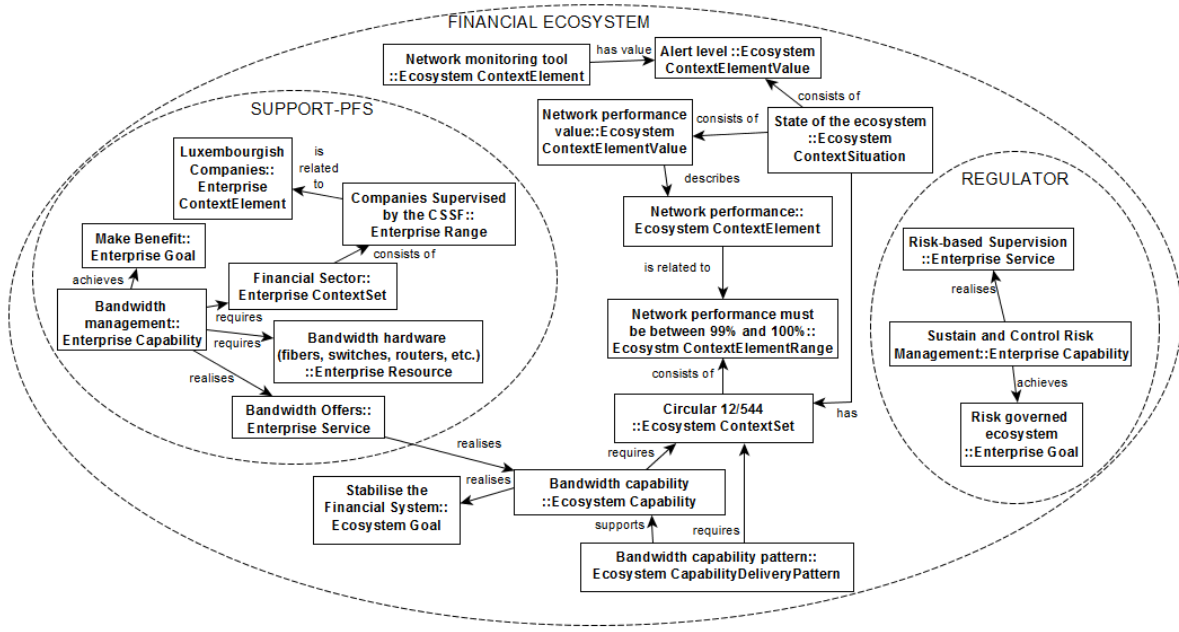
Figure 3. Extended Business Service Ecosystem metamodel instantiated to the financial